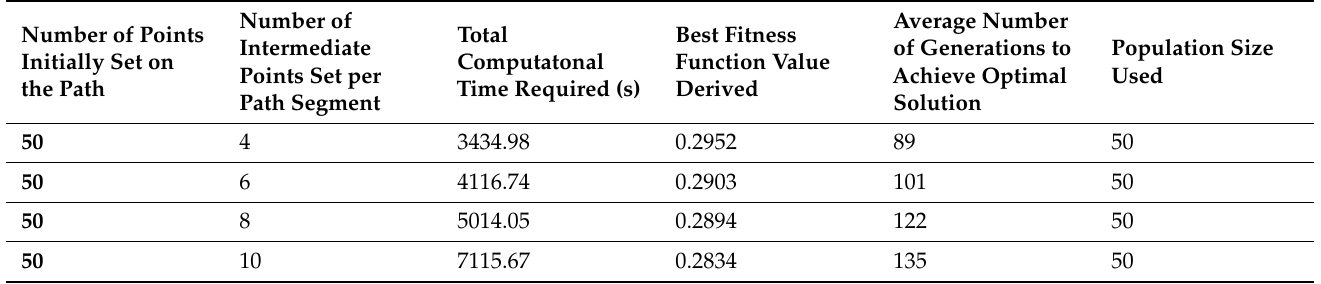
Table 4. Effect of the number of intermediate points inserted along the path on the optimization process for the path-following task.